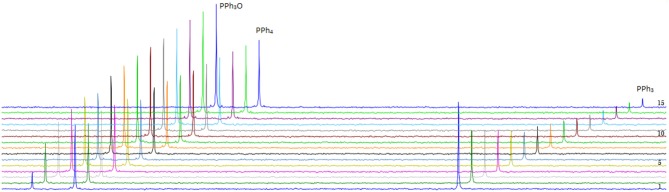
Transformation of PPh3 to OPPh3 catalyzed by 5 in the presence of PPh3 and DMSO-d6 as oxidizing agent monitored by 31P-NMR spectroscopy at r.t (unregulated temperature). Fifteen spectra are shown taken with a frequency of 1 every 4 h.